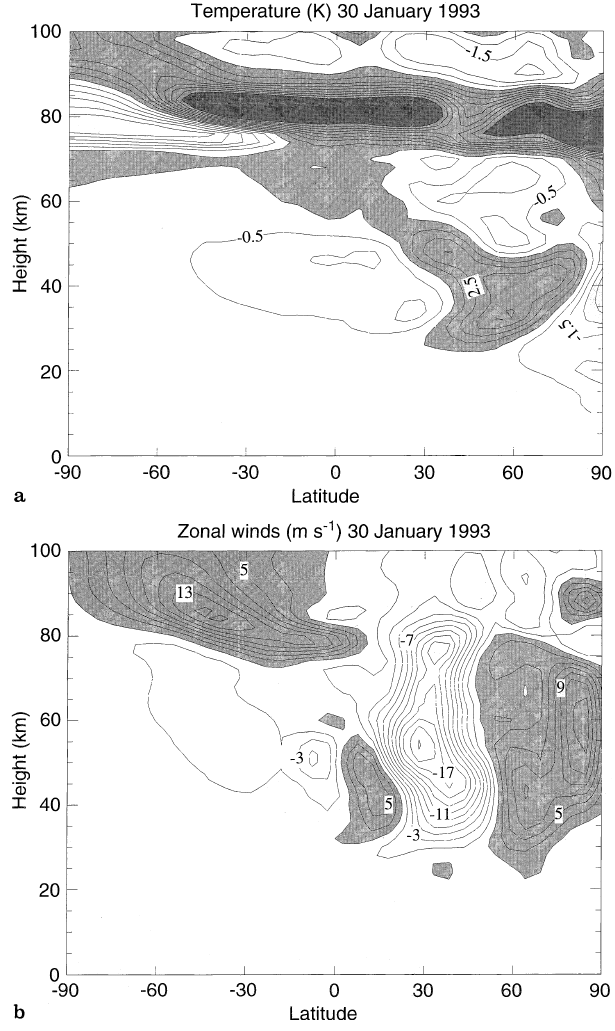
Fig. 4a,b. Zonally averaged di(cid:128)erences in a temperature (K), b zonal velocity (ms ) 1 ) from the EMM after 60 days of model integration between solar maximum and solar minimum. Light shading denotes values of 0.5 K and 1ms ) 1 and more respectively and dark shading greater than